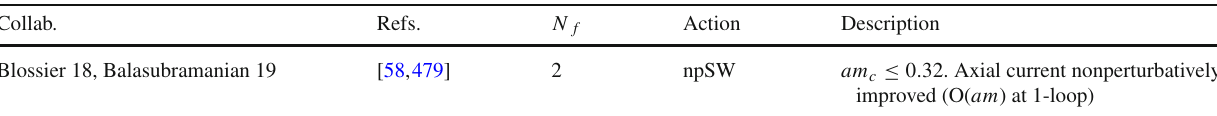
Table 134 Heavy-quark treatment in N f = 2 determinations of the D - and D s -meson decay constants Collab.